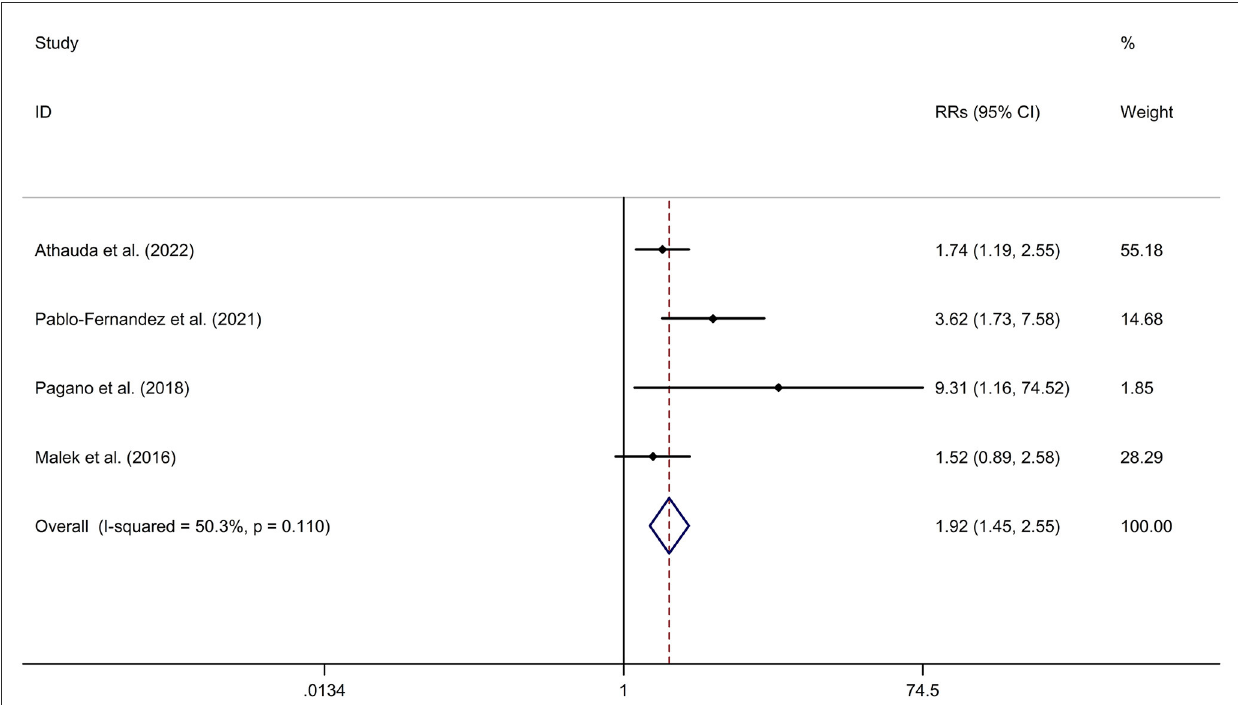
FIGURE5 Forest plot for association between DM and cognitive decline of PD. CI, confidence interval; DM, diabetes mellitus; PD, Parkinson’s disease; RR, relative